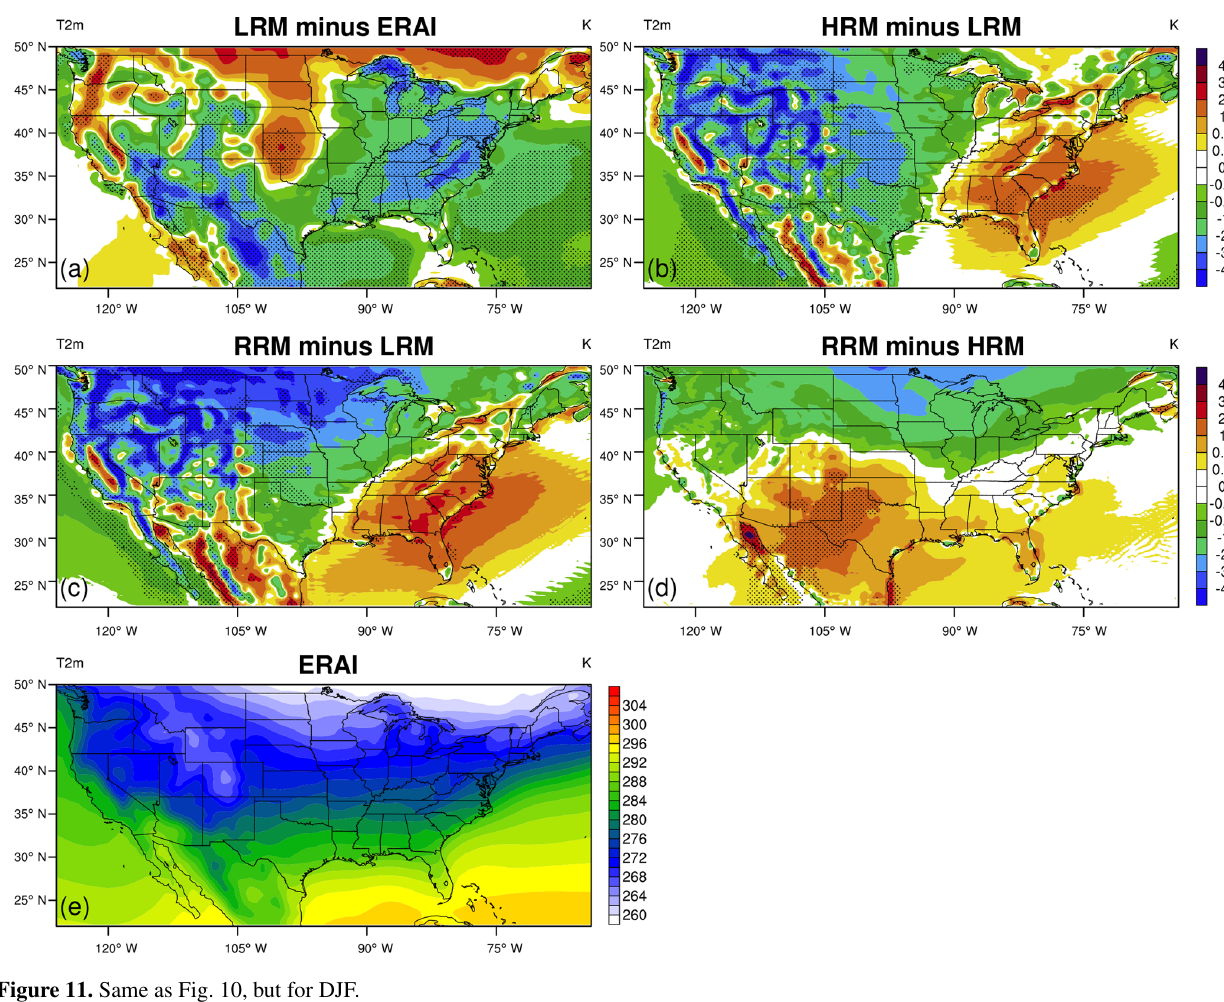
Figure 11. Same as Fig. 10, but for DJF.